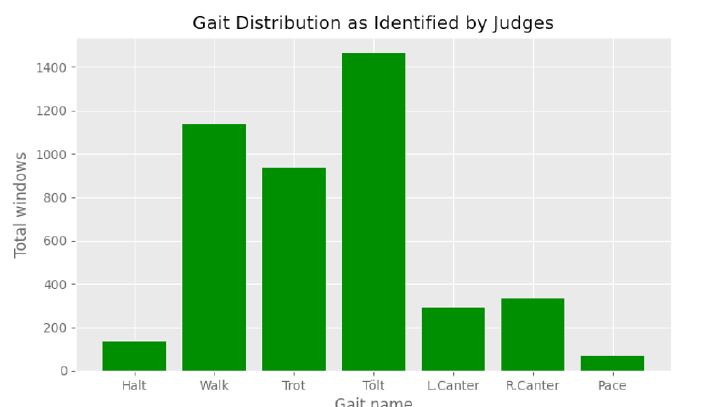
Figure 9. Distribution of gaits as identified by the judges. We note that pace is